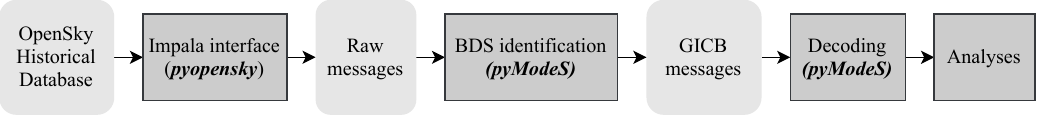
Figure 1. Data processing